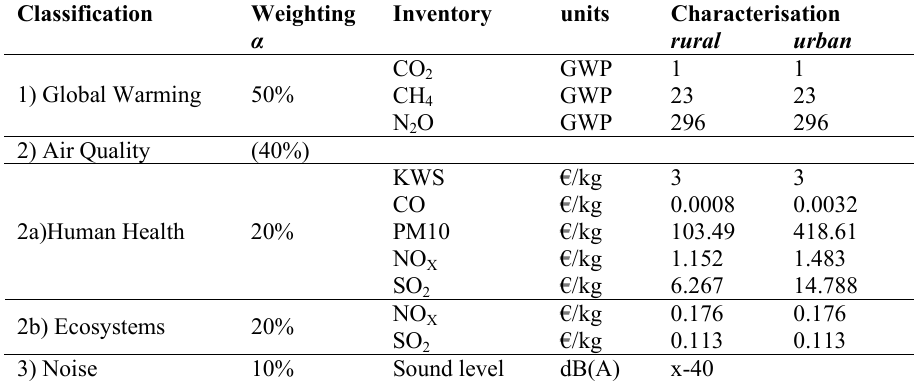
Table 4. Summary of the parameters used for the Ecoscore methodology Classification